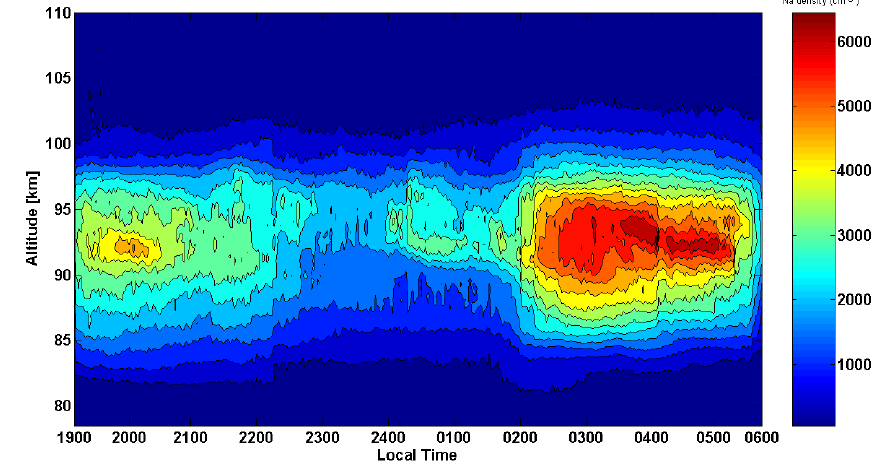
Fig. 8. Mean Nocturnal evolution of mesospheric sodium layer as obtained from lidar observations in 2005 and